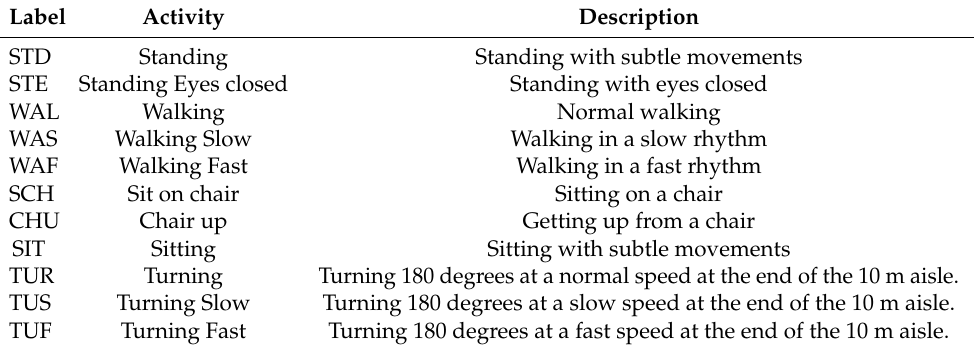
Table 3. Activities of daily living (ADLS): annotation of Smart-Insole dataset, Level 1.